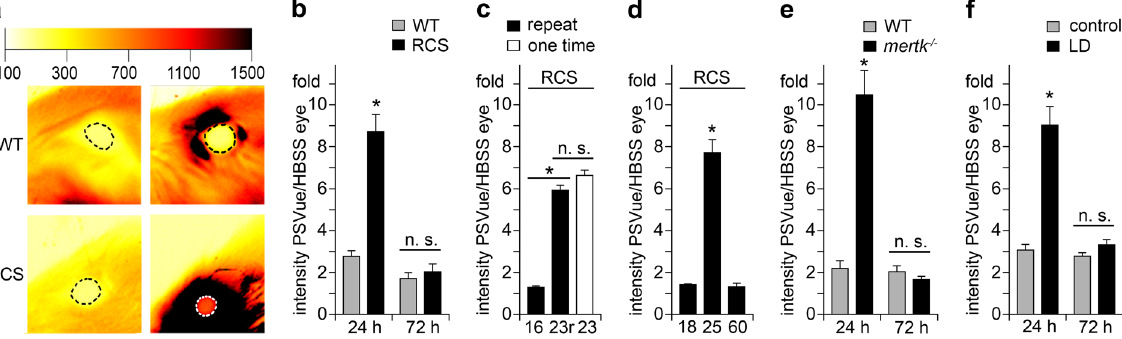
Figure 2. Live imaging of apoptotic photoreceptors in vivo by whole animal scanning. ( a ) Representative whole animal scans of p25 RCS and WT rats 24 hours after PSVue-550 or HBSS buffer eyedrop application as indicated. Intensity range on top shows false color scale. Encircled regions show quantified areas. ( b ) Quantification of fluorescence intensity as in ( a) of p25 rats 24 and 72 hours after PSVue-550 application; n = 7 animals per group. ( c ) Quantification of fluorescence intensity 24 hours after eyedrops of RCS rats treated with PSVue-550 or HBSS eyedrops at p16 (16) with repeat at p23 (23r, black bar) side by side with p23 siblings that had not been treated before (23, white bar); n = 6 animals per group. ( d ) Quantification of fluorescence intensity 24 hours after eyedrops of RCS rats at p18, p25, and p60 as indicated; n = 5 animals per group. ( e ) Quantification of fluorescence intensity 24 and 72 hours after PSVue-550 application in pigmented mertk − / − mice; n = 9 animals per group. ( f ) Quantification of fluorescence intensity 24 and 72 hours after PSVue-550 application in LD rats; n = 7 animals per group. ( b – f ) All bars show mean ± SEM. All asterisks indicate P < 0.05 by ANOVA and Tukey post-hoc test. n.s. indicates difference not